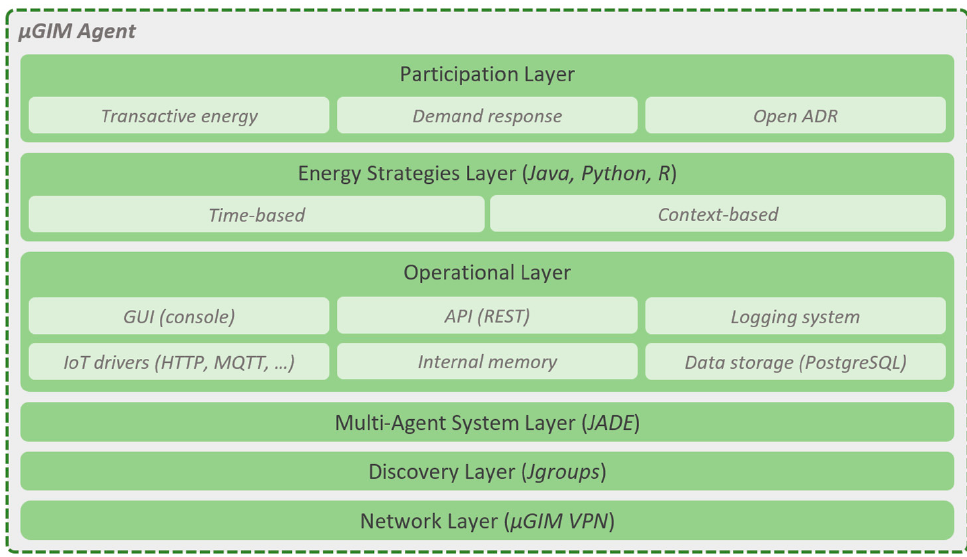
Figure 1. µGIM architecture viewed in layers. Figure 1. µ GIM architecture viewed in